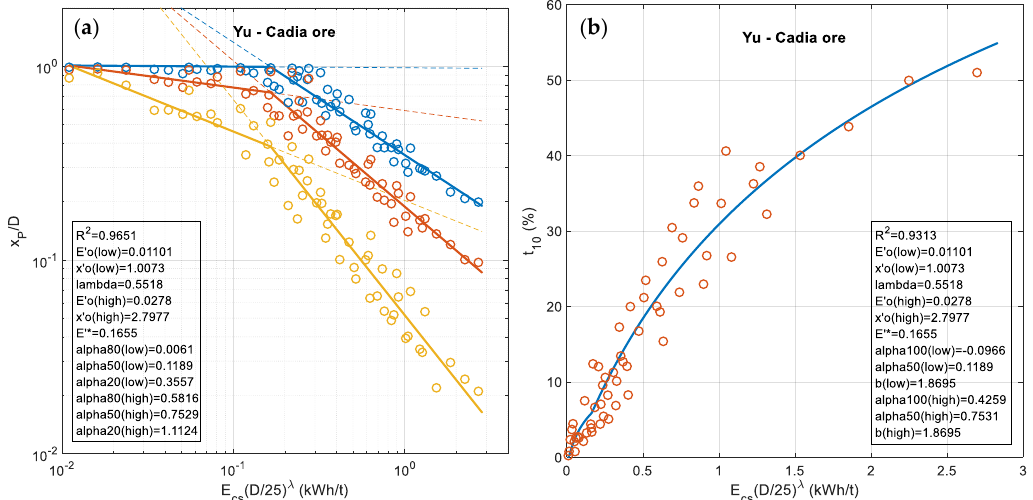
Figure 12. Basic double fragmentation-energy fan for Cadia ore ( a ) and corresponding BIE ( b ), 𝑅 2 = 0.9313. The number of sieving curves secondly, 59 is by far the largest for the new